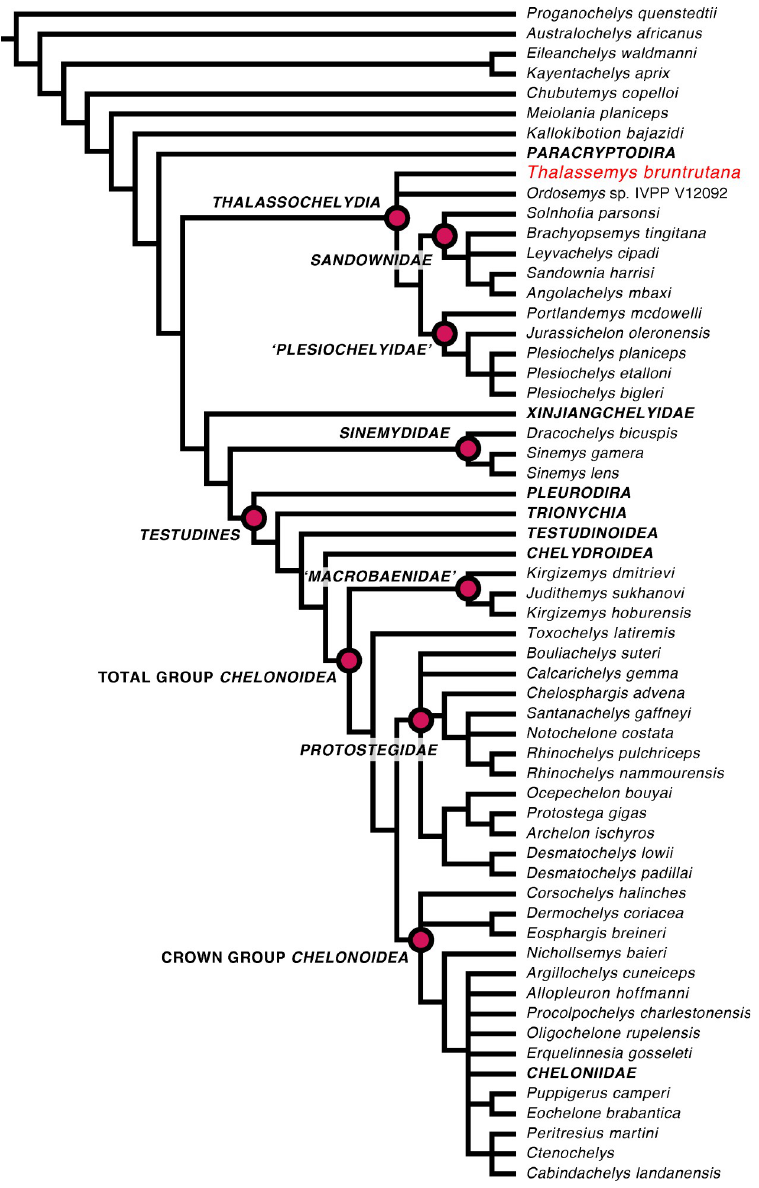
Fig 4. Strict consensus of 5940 MPTs of 1743 steps showing the phylogenetic placement of Thalassemys bruntrutana as well as important clades and taxa discussed in the text. Note that terminal clades in bold were been collapsed to save space (see S4 Appendix for full topology). Important internal nodes are labelled. ‘Plesiochelydidae’ is placed in single quotes to indicate that is does not have a formal phylogenetic definition. ‘Macrobaenidae’ is also placed in single quotes because the specifier for this clade, Macrobaena mongolica , is not included. However, the respective taxa are commonly labelled as ‘macrobaenids’ in the